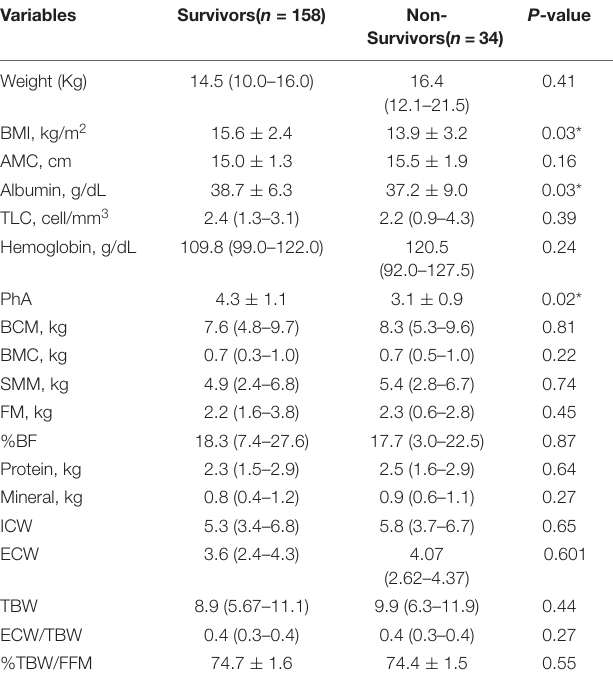
TABLE 2 | Comparison of the nutritional indicators and BIA measurements between 90-day survivors and non-survivors.